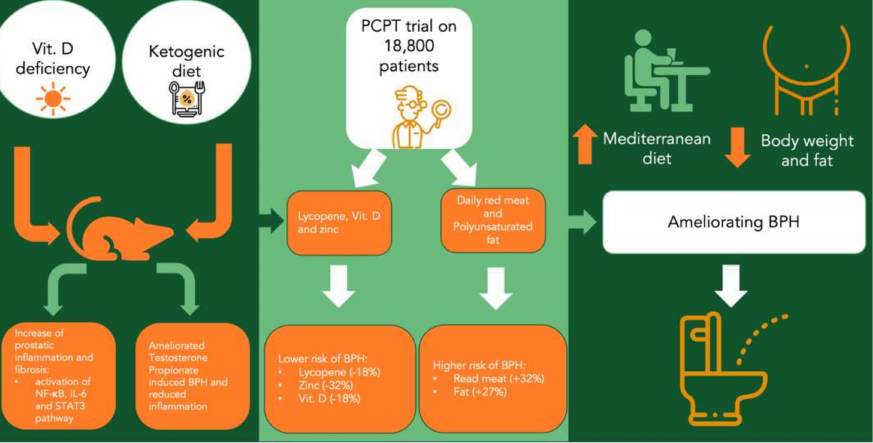
Figure 4. Relationship between dietary patterns and BPH. Relationship between dietary patterns and BPH. STAT3 = Signal Transducer And Activator Of Transcription 3; BPH = benign prostatic